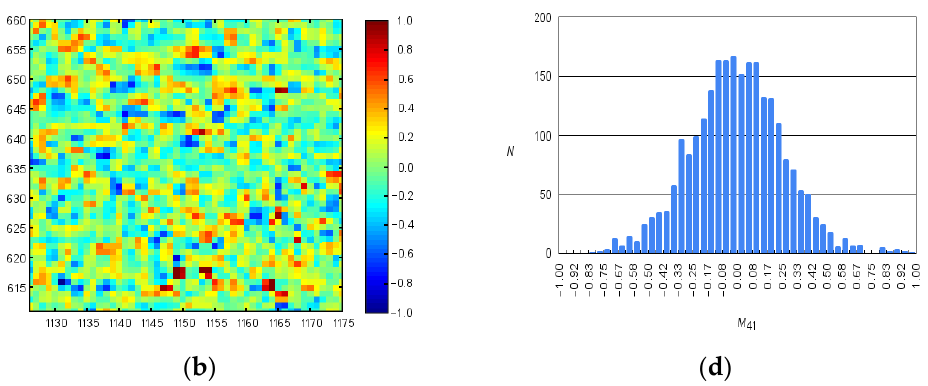
Figure 4. Coordinate distributions of invariants of the diffuser surface structure matrix M 14 ( a ) ,